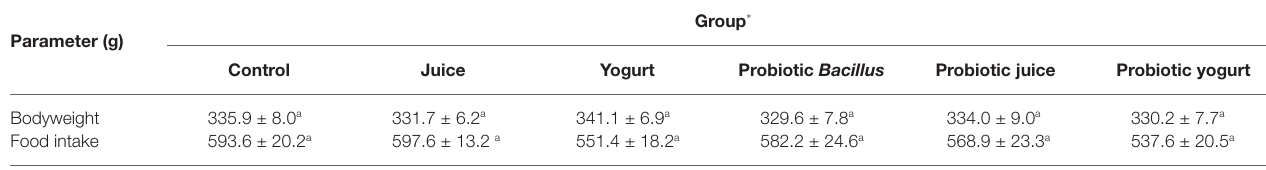
TABLE 1 | Bodyweight and food intake of healthy Wistar male rats after 21 days of administration of juice, probiotic juice, yogurt, and probiotic yogurt.